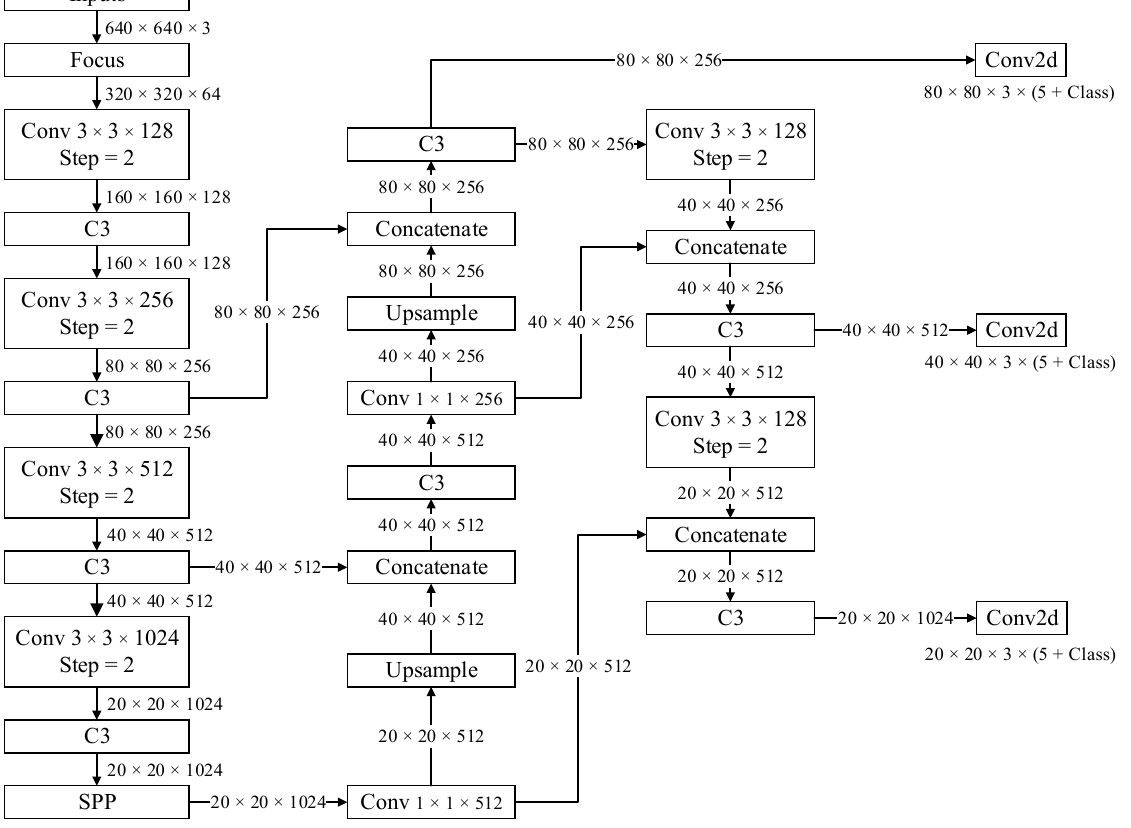
Figure 1. Traditional YOLOv5